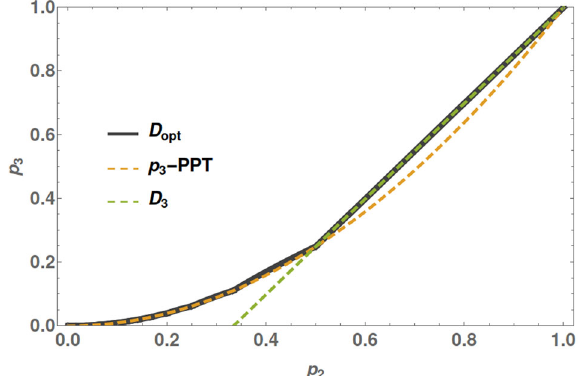
Fig. 2 Entanglement conditions of order three. The plot of the value of the third moment p 3 saturating the p 3 -PPT (dashed orange curve), the D 3 (dashed green line), and the optimal D opt curve) conditions as a function of the second moment p 2 for a normalized Hermitian matrix. According to the p 3 -PPT condition, any state ρ with a value of p 3 ( ρ Γ ) below the dashed orange curve is entangled. Similarly, the condition D 3 shows that any state ρ with a value of p 3 ( ρ Γ ) below the dashed green line is entangled. From this plot, it is clear that, for p 2 ( ρ Γ ) > 1/2, all entangled states detected by the